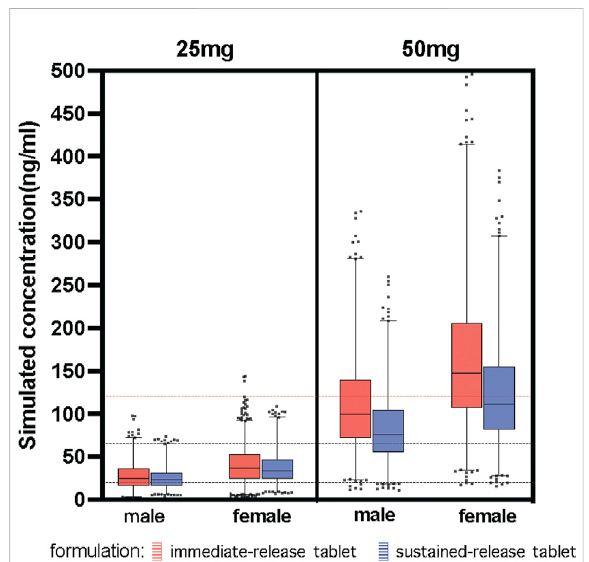
FIGURE 4 Simulated concentration about covariates identi fi ed.